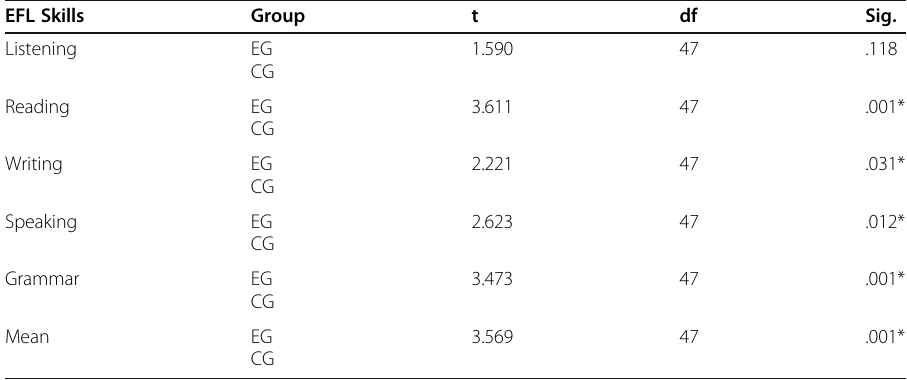
Table 4 Independent samples post-tests statistics EFL